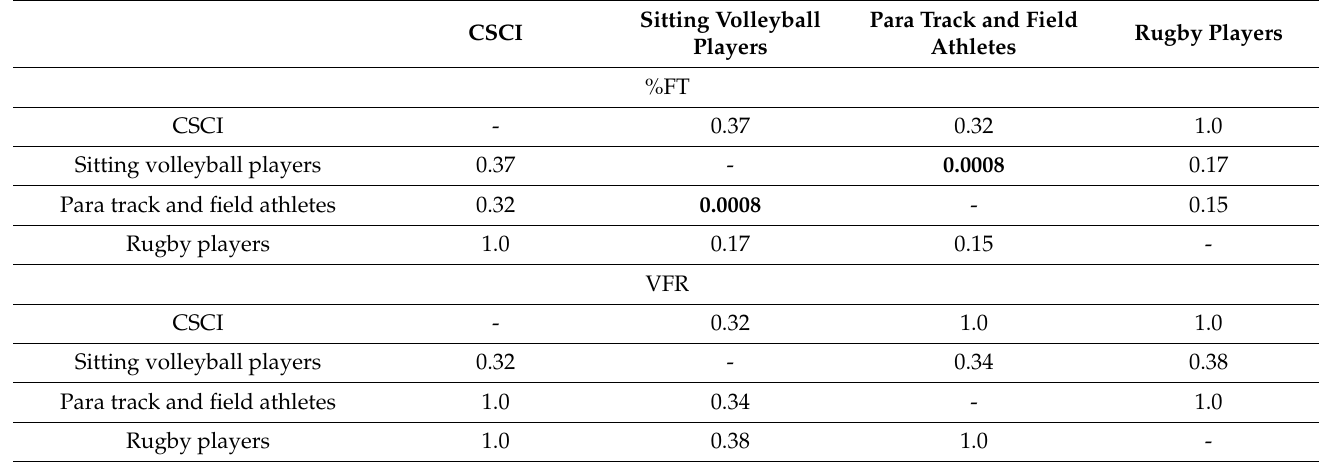
Table 4. Post hoc test for multiple comparisons of body